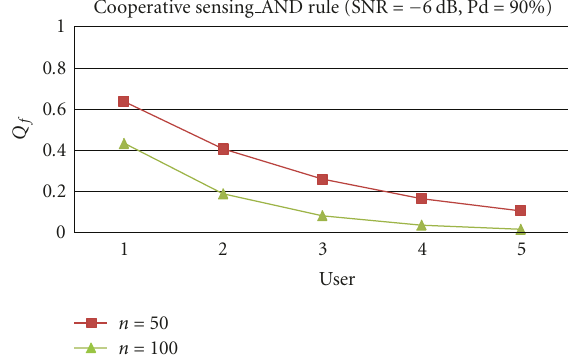
Figure 11: Performance of probability of false alarm using AND- rule cooperative sensing at di ff erent sample sizes.